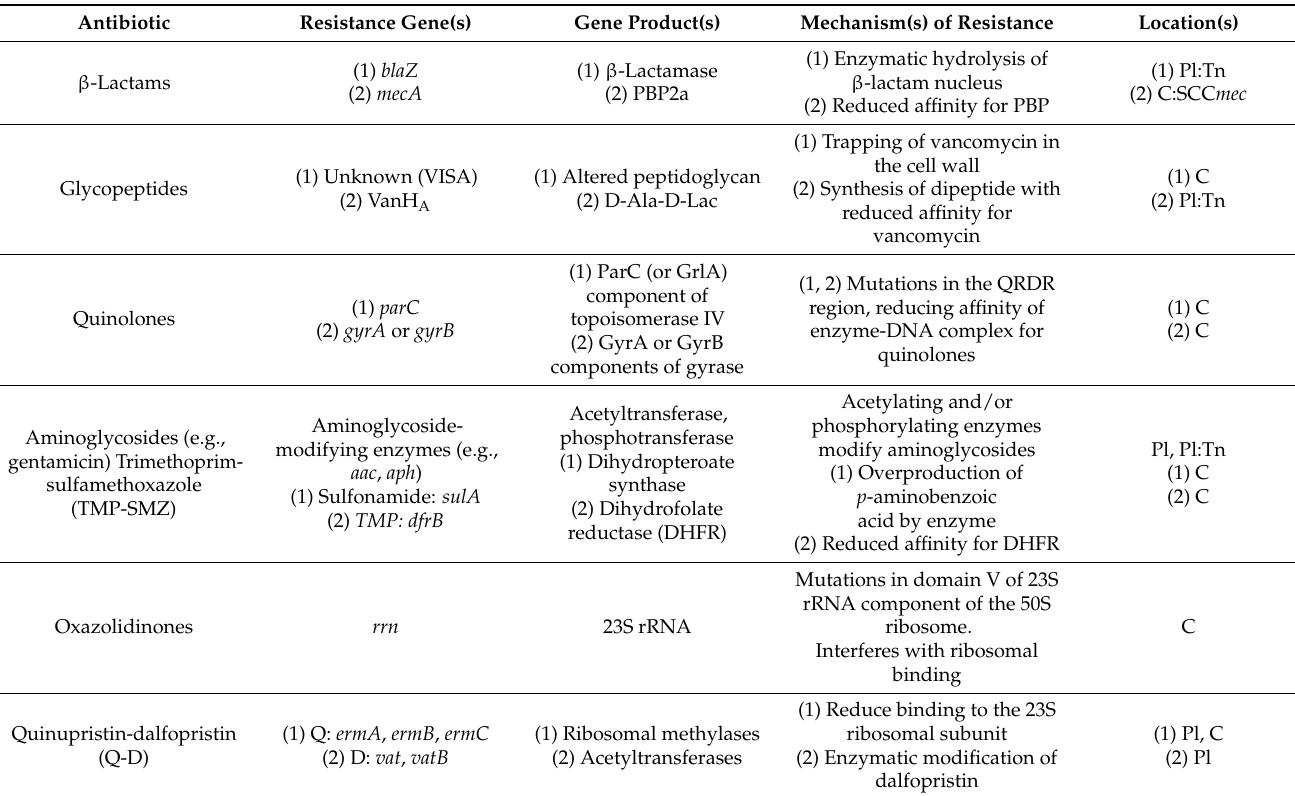
Table 1. Examples of several of the S. aureus mechanisms of resistance to selected